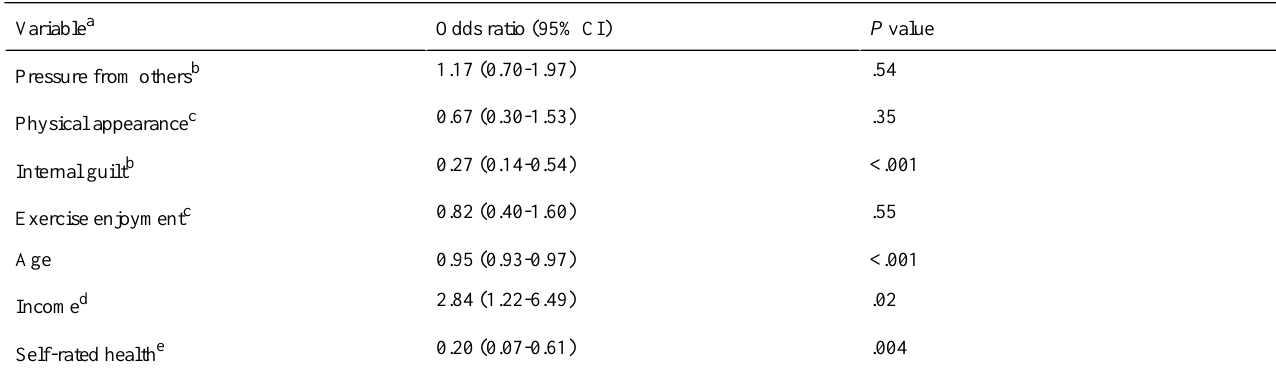
Table 2. Results from multivariable regression modeling of exercise motivations and previous wearable activity tracker use